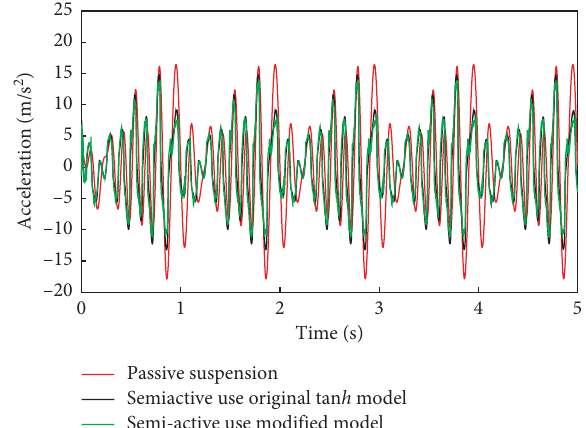
Figure 20: The acceleration contrast of seat upper surface.